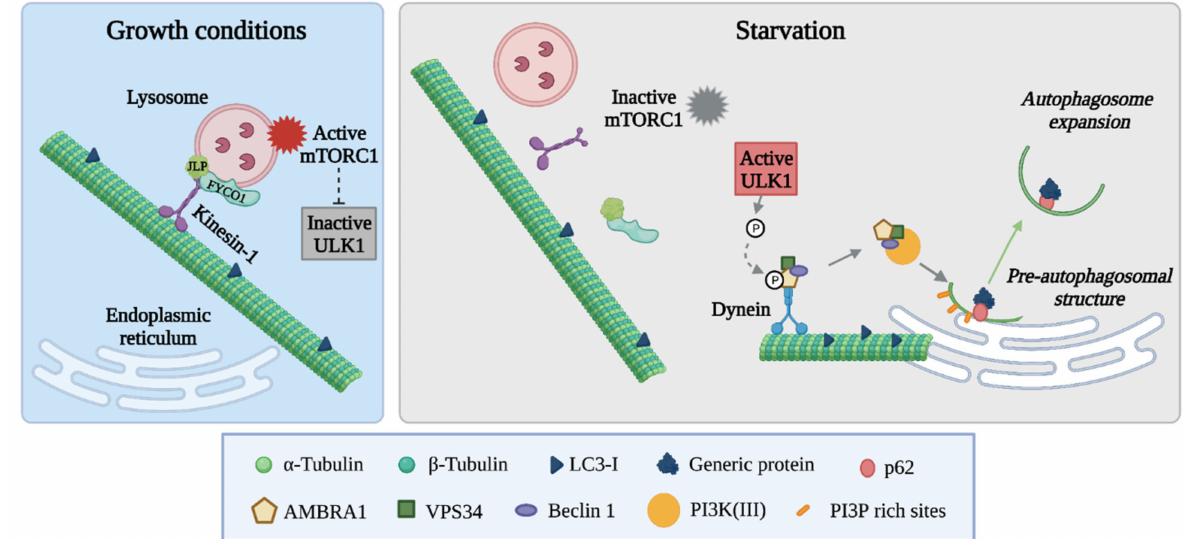
Figure 2. MTs regulate the initiation of autophagy. In normal growth conditions (left panel), lyso- somes are maintained at the cell periphery through their FYCO1- and JLP-mediated interaction with the plus-end-directed kinesin 1 and MTs. In these conditions, the lysosome-associated mTORC1 complex is active and inactivates the ULK1 complex. Upon starvation (right panel), lysosomes detach from kinesin 1 and the mTORC1 complex becomes inactive. This stimulates ULK1-dependent phos- phorylation of AMBRA1, releasing AMBRA1 from dynein interaction and allowing the translocation of the PI3K complex, comprising Beclin 1/VPS34/AMBRA1, to the endoplasmic reticulum, where it promotes membrane formation at PI3 rich sites. Image created with